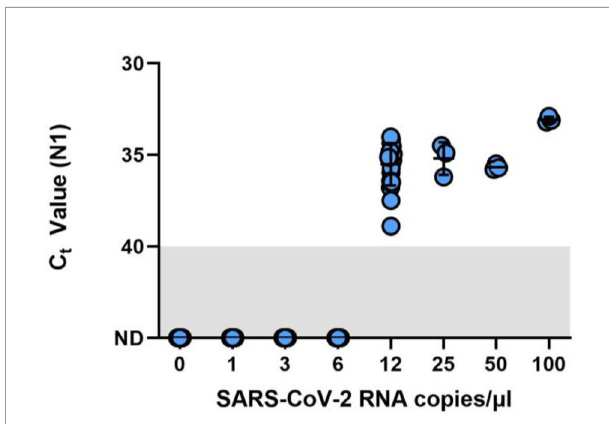
FIGURE 1 | Limit of detection (LOD) fi nding study for the SalivaDirect protocol adapted for RT-PCR testing by the Liberty16 instrument. A SARS- CoV-2 positive saliva specimen with a known virus concentration (3.7 × 10 4 copies/µL) was spiked into saliva negative for SARS-CoV-2 to create the following 2-fold dilution series: 100, 50, 25, 12.5, 6.25, 3.125, and 1.5 copies/µL. Spiked saliva samples were tested in triplicate to determine the preliminary LOD using the SalivaDirect protocol and tested using the NEB Luna 2x PCR mastermix and run on the Liberty16 system using the